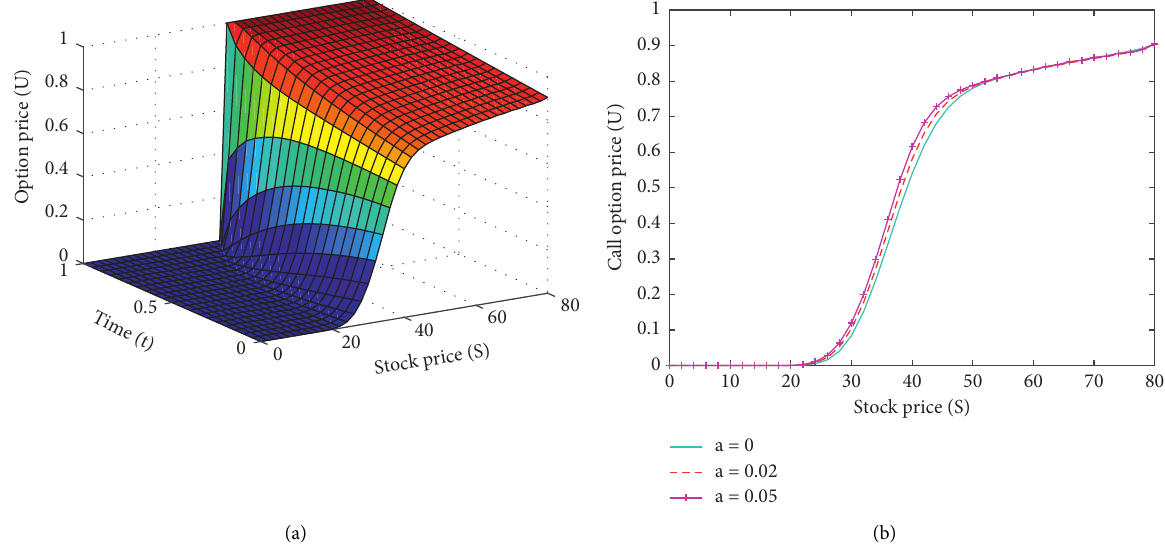
Figure 4: (a) European cash-or-nothing option price charts of the explicit nonstandard method for a � 0 . 05 and (b) cash-or-nothing charts of the explicit nonstandard method for different transaction costs in t �